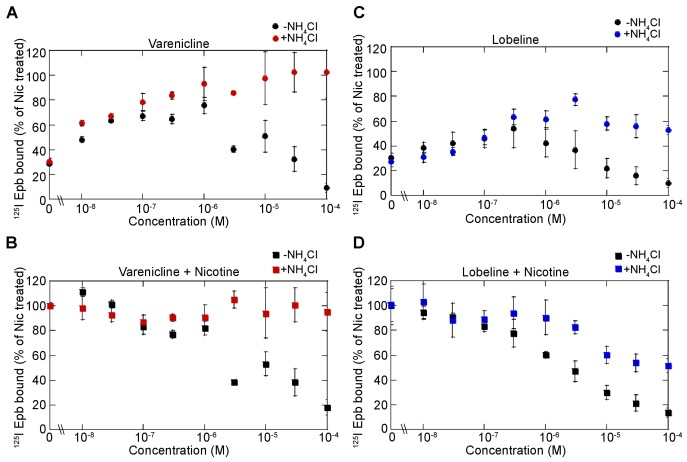
Dose dependence of varenicline and lobeline effects on upregulation.(A) Dose dependence of varenicline upregulation. α4β2R-expressing cells were treated with increasing concentration of varenicline for 17 hr. Cells were washed with PBS prior to 125I-epibatidine binding and with (red-filled circles) or without 20 mM NH4Cl (black-filled circles) treatment for 10 min (n = 3). (B) Dose dependence of varenicline on nicotine upregulation. Cells were treated with increasing concentration of varenicline with 10 μM nicotine for 17 hr and treated with (red-filled squares) or without 20 mM NH4Cl (black-filled squares) treatment for 10 min as in (A) (n = 3). (C) Dose dependence of lobeline upregulation. α4β2R-expressing cells were treated with increasing concentration of lobeline for 17 hr and treated with (blue-filled circles) or without 20 mM NH4Cl (black-filled circles) treatment for 10 min as in A (n = 3). (D) Dose dependence of lobeline on nicotine upregulation (n = 3). For all the points in (A, B, C, D): error bars represent mean ± s.e.m. n indicates number of independent experiments performed on separate days and cultures.